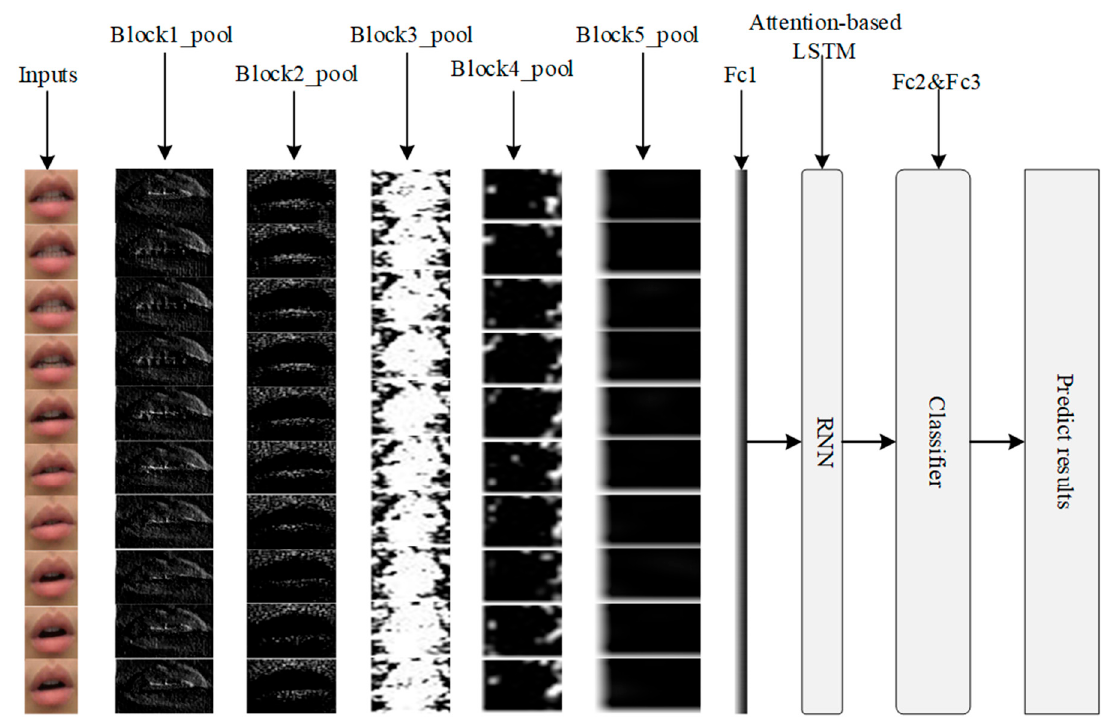
Figure 6. The visualization processes of feature extraction.